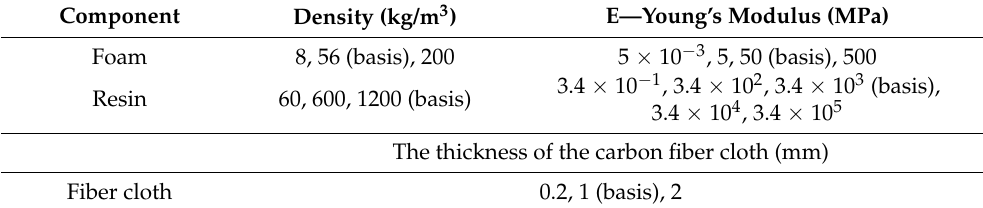
Table 3. The parameter discussion of the corrugated sandwich